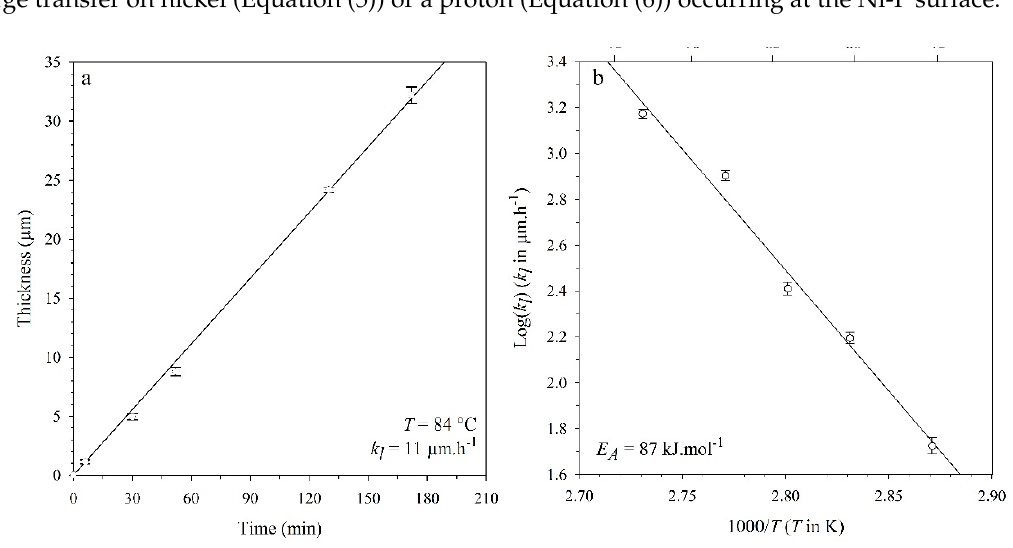
Figure 3. ( a ) Thickness of the scale vs. time; ( b ) Arrhenius plot.